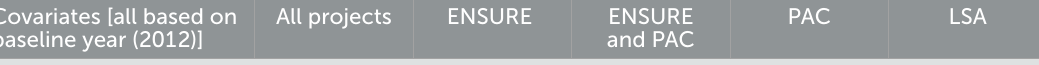
TABLE 4 Drivers of participation in World Vision projects (marginal effects). Covariates [all based on All projects ENSURE ENSURE baseline year (2012)]